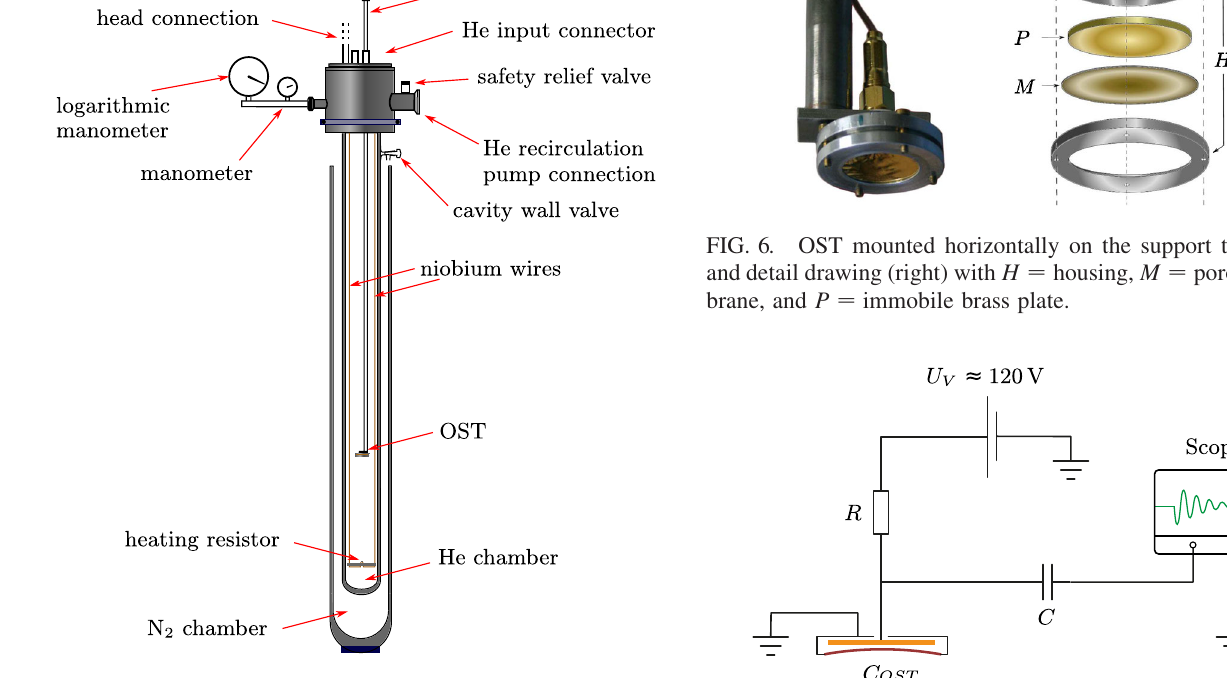
FIG. 5. Sketch of the He evaporation cryostat with mounted OST and heat source.